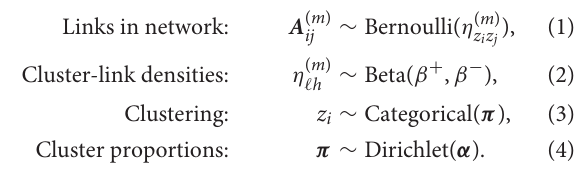
subjects. We have previously found this atlas to perform